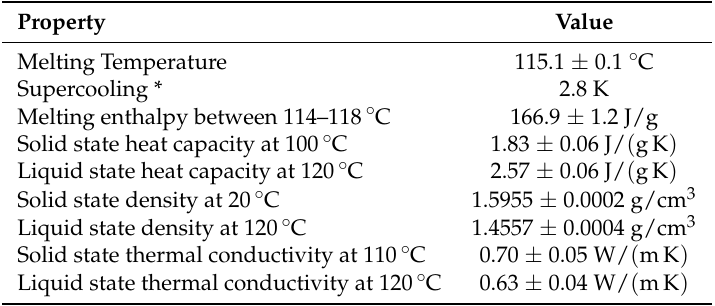
Table 1. Thermophysical properties of the applied PCM MCHH (adapted from [11]).